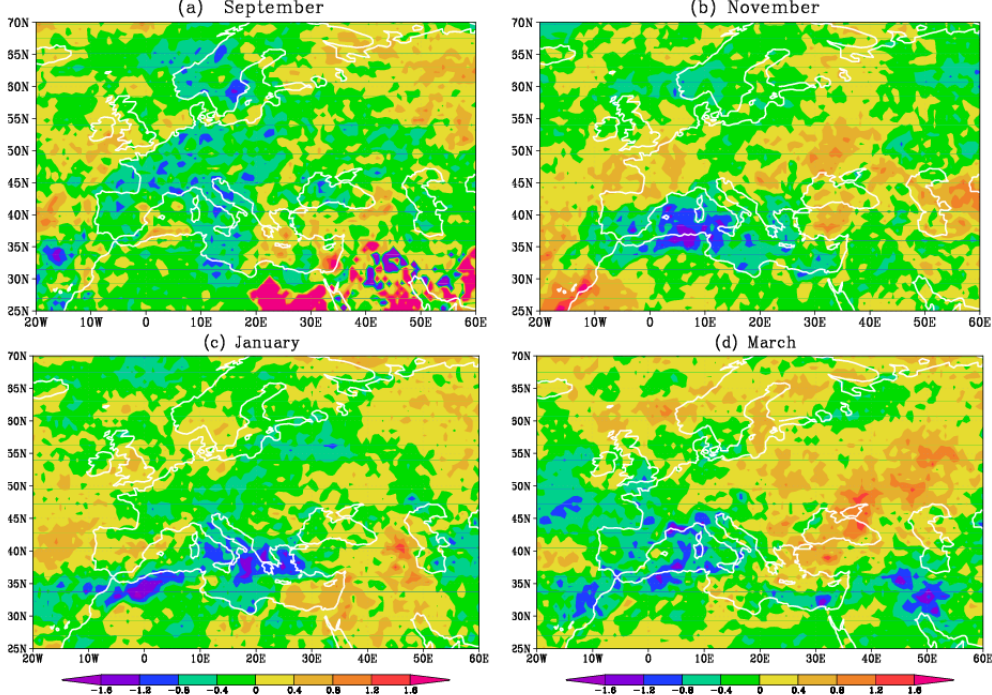
Figure 6. Climate change trend (2021–2050 minus 1961–1990) in frequency of days with extreme precipitation in (a) September, (b) Novem- ber, (c) January and (d) March. The color bar presents values from − 1.6 to + 1.6daysmonth − 1 with 0.4 interval (Fig. 3.16 in Gualdi et al., 2012; used with permission from